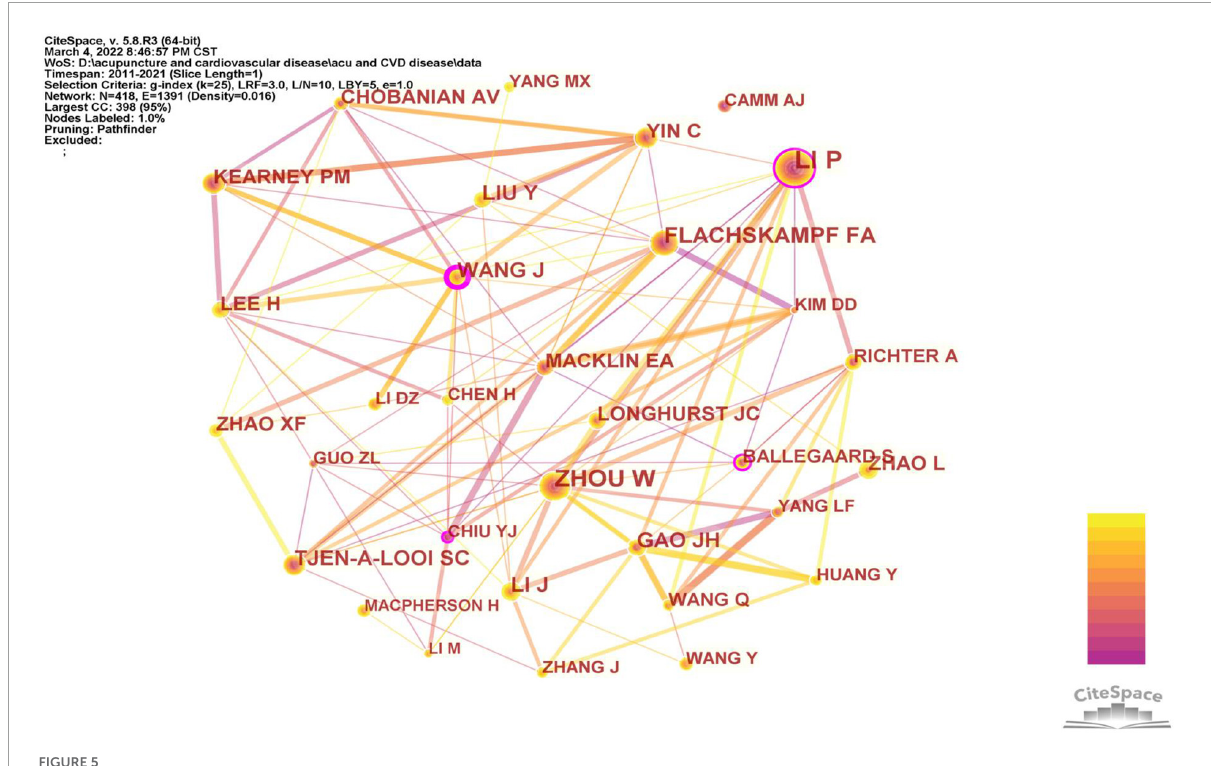
FIGURE5 Network map of co-cited authors about acupuncture on cardiopathy.